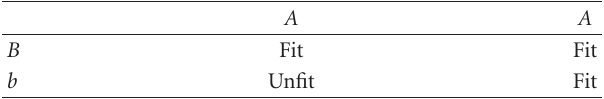
Table 1: Simple Dobzhanksy-Muller incompatibility. With this type of genetic architecture, it is possible to evolve from one high fitness genotype ( AB ) to another ( ab ) without passing through any fitness valleys (by AB → aB → ab ). Matings between two high fitness types yield unfit hybrids (i.e., AB × ab produces the unfit type Ab ). A A B Fit Fit b Unfit